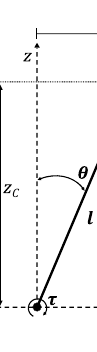
Figure 7. Linear Inverted Pendulum Model (LIPM).